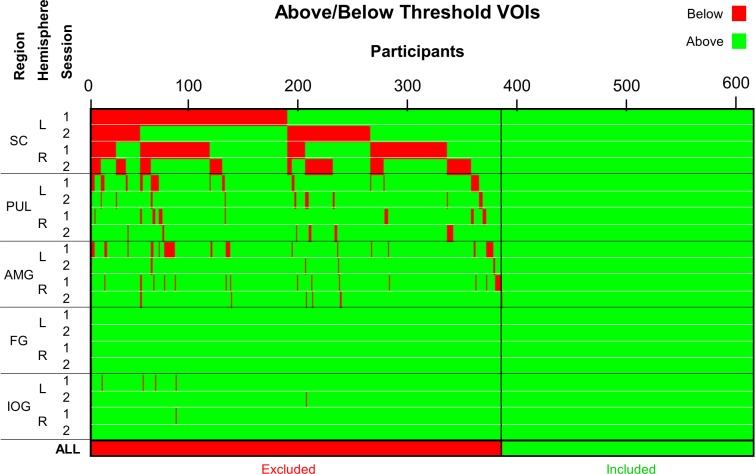
Participants with above or below threshold fMRI signal in all VOIs for inclusion into DCM stage.Threshold was set at p<0.05 uncorrected, using the [Faces – Shapes] contrast. Each column is a participant (N = 622) and each row is a different region (SC = superior colliculus, PUL = pulvinar, AMG = amygdala, FG = fusiform gyrus, IOG = inferior occipital gyrus) with two sessions each (i.e. each fMRI run) per hemisphere (L = left, R = right). Red indicates below-threshold signal and green indicates above-threshold signal. The bottom row (‘ALL’) indicates whether the participants were included or excluded from further DCM analysis, based on whether they had any below-threshold VOIs.